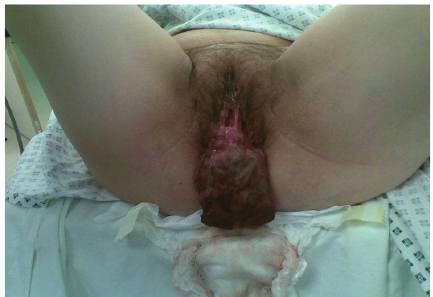
Figure 1: Large necrotic fibroid which was expelled with a long pedicle hanging from the uterine fundus, approximately six weeks after an emergency caesarean